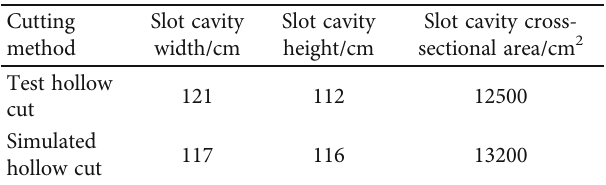
Figure 7: Contour of blast cavity.